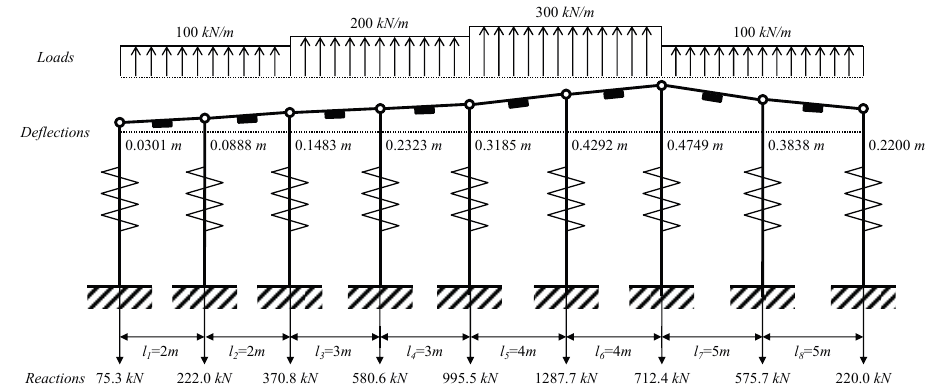
Figure 9. Deformed shape of an 8-span beam subjected to distributed lateral loads.